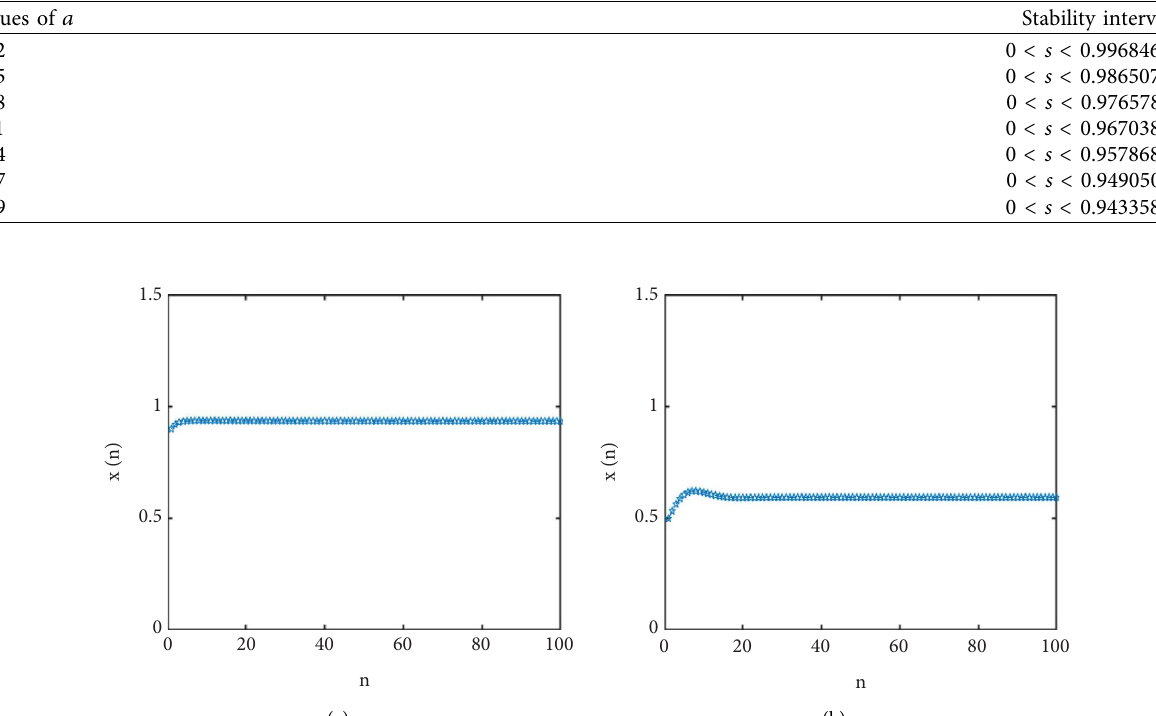
Figure 17: (a) Time sequence diagram for the state x of the controlled model (120) for r � 2 . 9 , ε � 4 . 5 ,a � 0 . 2 and s � 0 . 2. (b) Time sequence diagram for the state x of the controlled model (121) for r � 3 , ε � 3 . 4 , a � 1 . 778 and s � 0 .